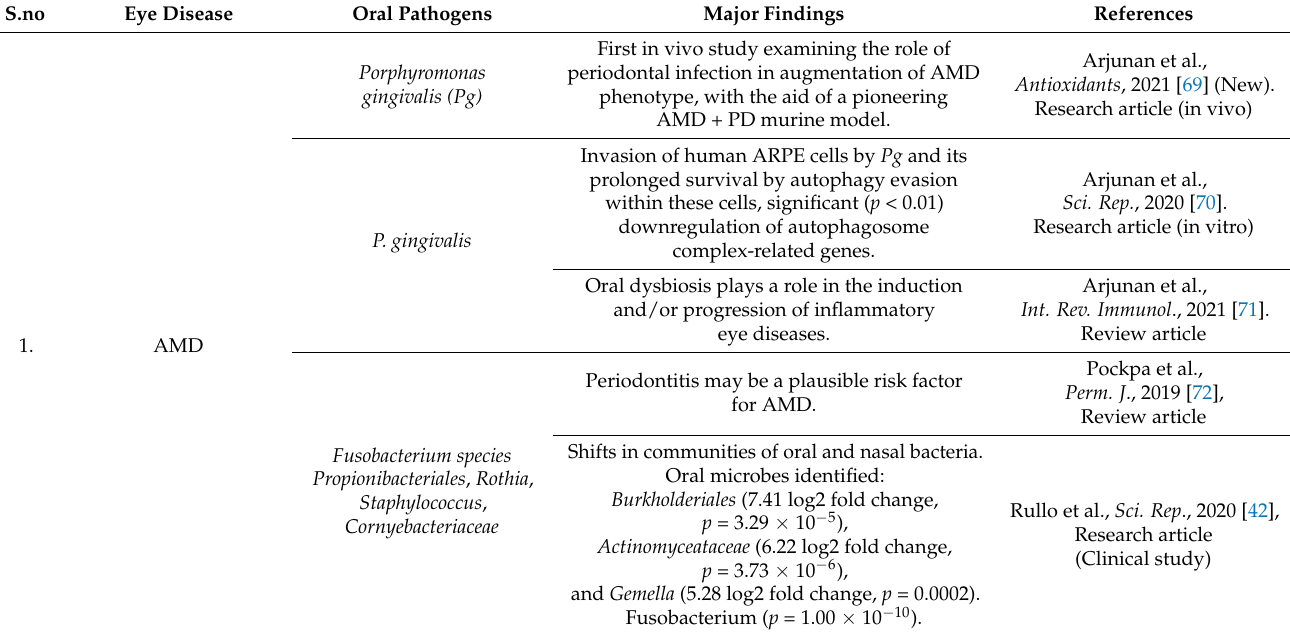
Table 2. Oral pathogens in ocular